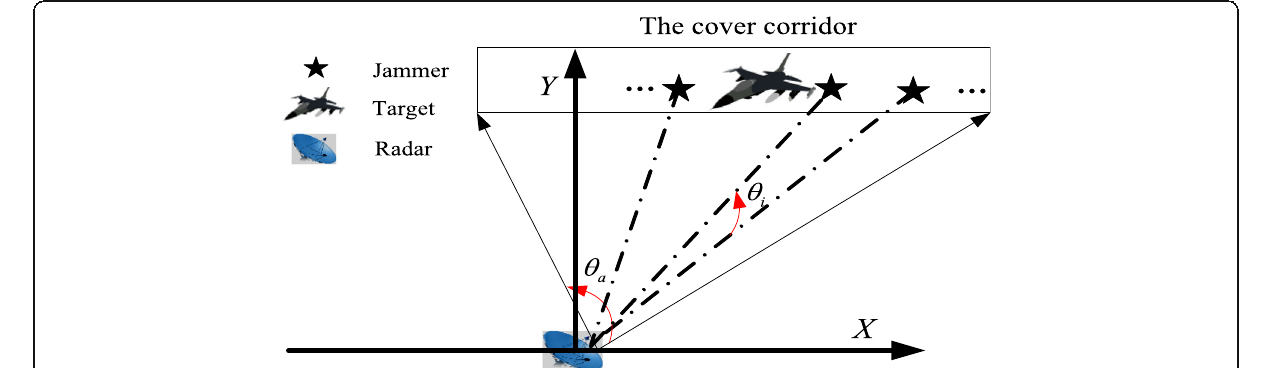
Fig. 4 Time-cooperative jamming generated by multiple